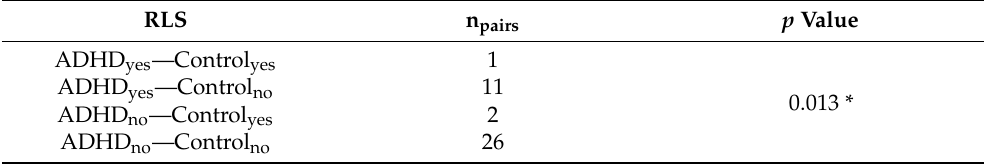
Table 6. Comparison of restless legs syndrome (RLS) between ADHD and control group. RLS